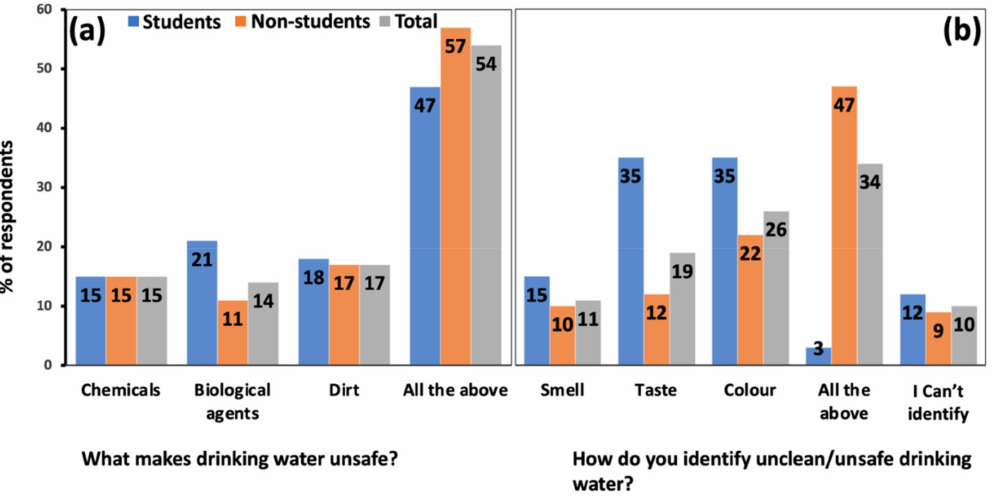
Figure 5. The percentage of respondents indicating their knowledge on what makes drinking water unsafe ( a ) and how to identify it ( b